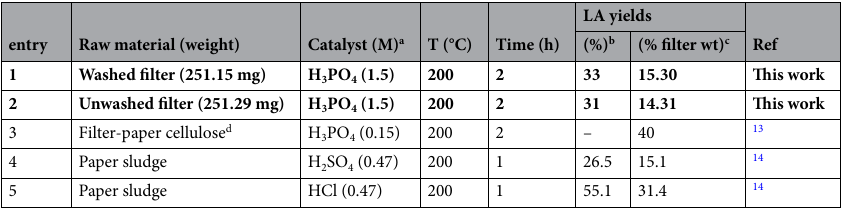
Table 2. Synthesis of levulinic acid from smoked cigarette filters. Procedure as reported in experimental section. a Volume = 15 mL. b Referred to theoretical amount of LA (see “Materials and methods” section). c Referred to the filter weight 14 . All yield values were obtained based on three replicate experiments (SD ± 2.0). d The pretreatment temperature and time were set to 50 °C and 24